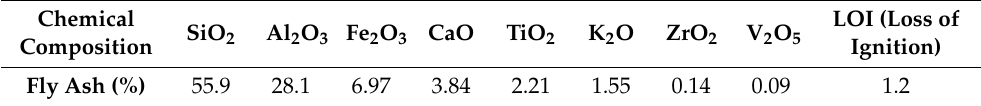
Table 1. Chemical composition of the fly ash.